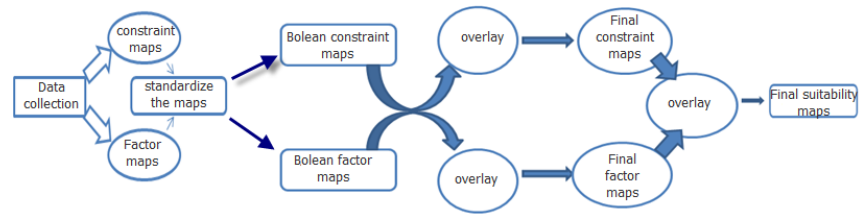
Figure 3. Flowchart of the methodology followed in the